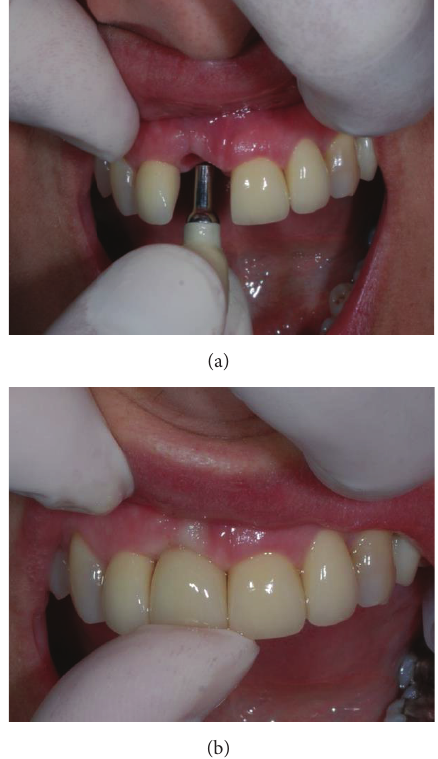
Figure 25: The abutment and crown were inserted through the long axis of the implant well (a) and then manually pressed (b) before tapping with mallet.